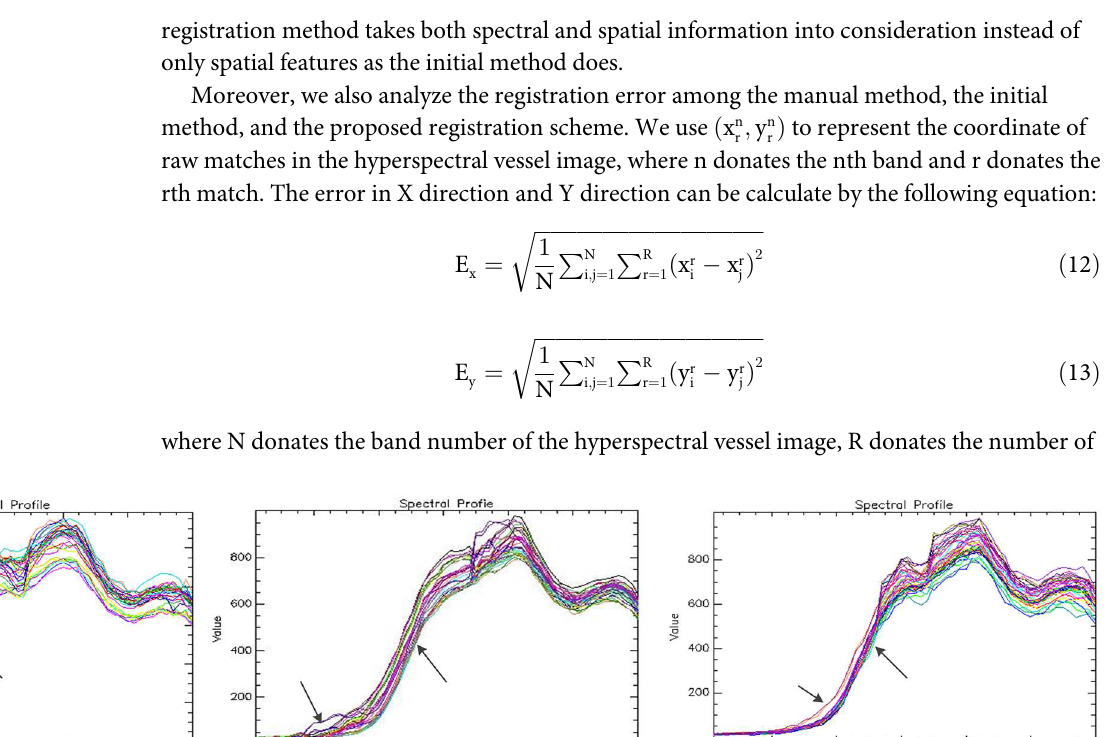
Fig 5. (a) splice of the 1st bandand the 8th band, (b) the binary image of the 8th bandafter registration.